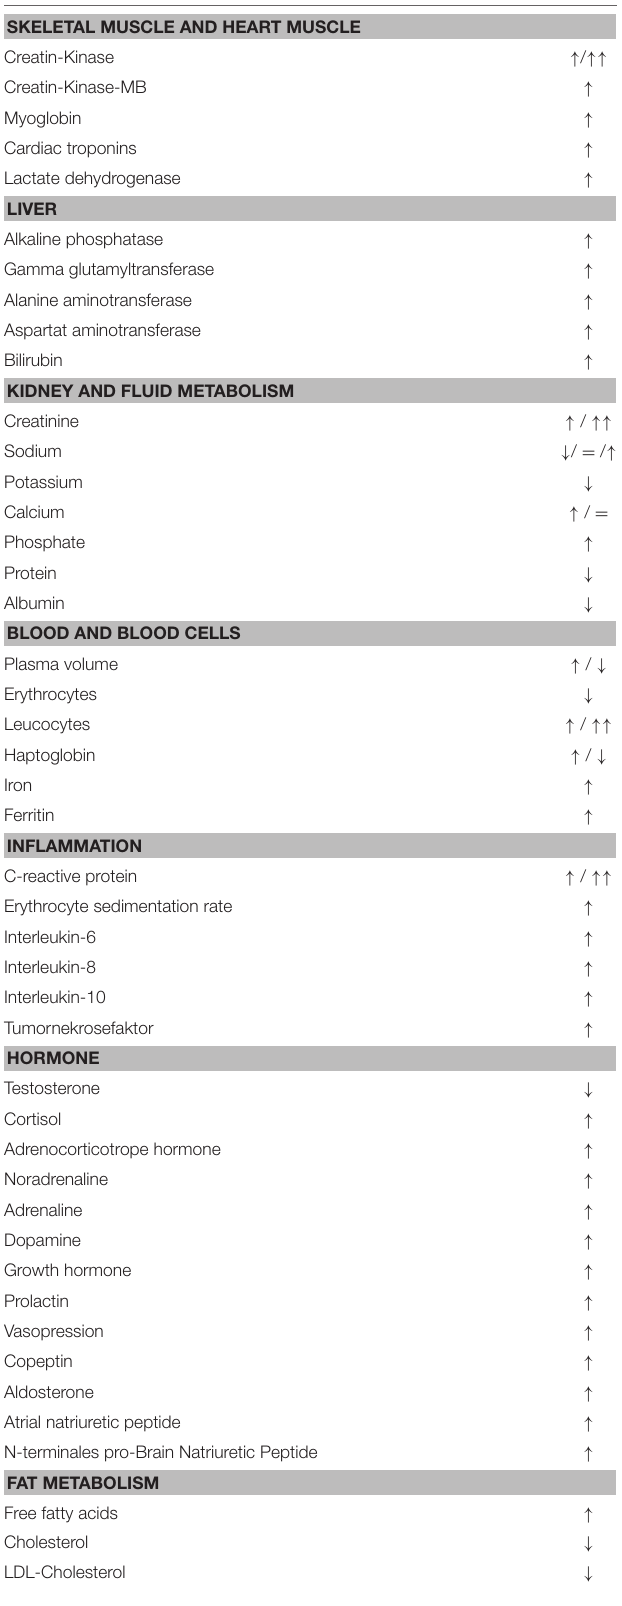
TABLE 9 | Changes in metabolites and hormones during an ultra-marathon. SKELETAL MUSCLE AND HEART